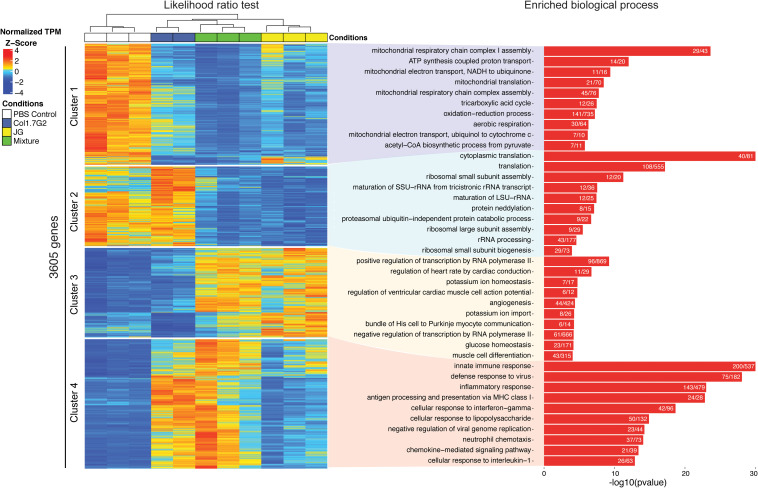
Analysis of enriched Gene Ontology categories represented by the differentially expressed genes. All genes from the Col1.7G2, JG, and mixture groups were analyzed in accordance with their Gene Ontology terms using the topGO package for R. The encountered GO terms derived from the up- and downregulated genes are shown in red and blue, respectively. The bars represent the -log10 values of the Fisher elim p-values (p < 0.01). Histogram values represent the number of differentially expressed genes based on the number of expressed genes in the background.